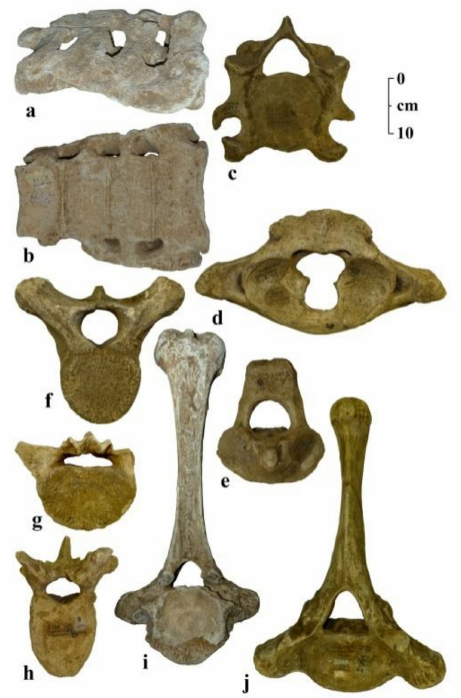
Figure 3. Isolated vertebra of mammoth Mammuthus intermedius from Kamensk-Shakhtinskiy (Rostov Region, Russia), the late Middle Pleistocene: ( a , b )—NMDC No. Pal-33, sacrum, lateral right view, ventral view, ( c )—NMDC No. Pal-41, fourth cervical vertebra, anterior view, ( d )—NMDC No. Pal-35, first cervical vertebra, anterior view, ( e )—NMDC No. Pal-36, second cervical vertebra, anterior view, ( f )—NMDC No. Pal-37, thoracic vertebra, anterior view, ( g )—NMDC No. Pal-39, lumbar vertebra, posterior view, ( h )—NMDC No. Pal-38, lumbar vertebra, anterior view, ( i )—NMDC No. Pal-21, thoracic vertebra, posterior view and ( j )—NMDC No. Pal-40, thoracic vertebra, anterior view.